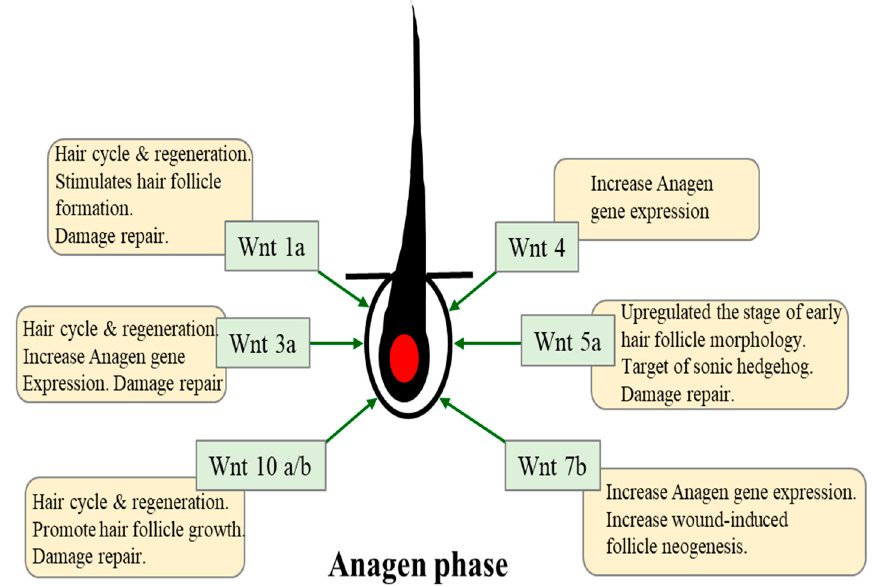
Figure 2. The role of various Wnts in hair growth cycle. Among the many signaling pathways implicated in HF development and growth, Wnt/ β -catenin signaling in dermal papilla (DP) cells plays a critical role in mutual communication between DP and epithelial cells. The different types of Wnt play variable roles in HF morphogenesis and